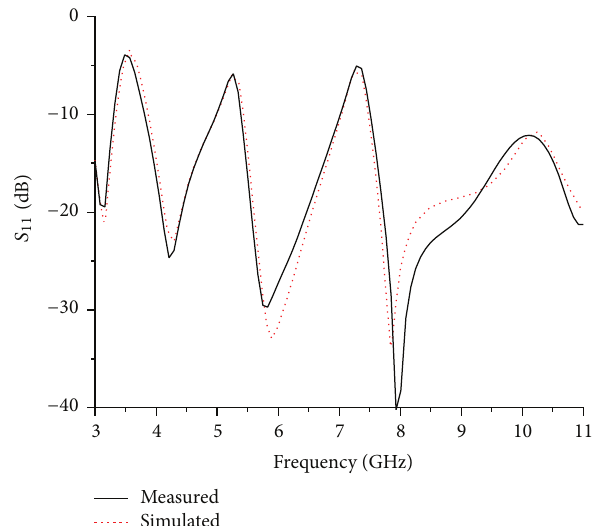
Figure 7: Simulated and measured 𝑆 11 of the proposed